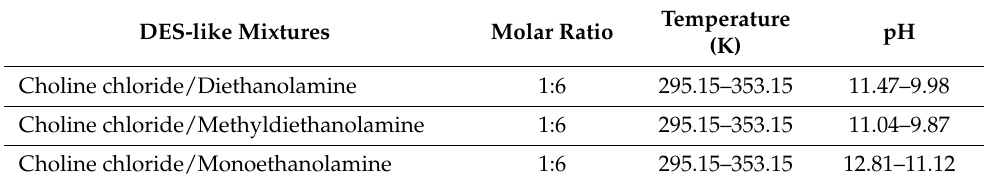
Table 7. pH values of DES-like mixtures depending on the temperature (adapted according to Adeyemi et al.) [32]. DES-like